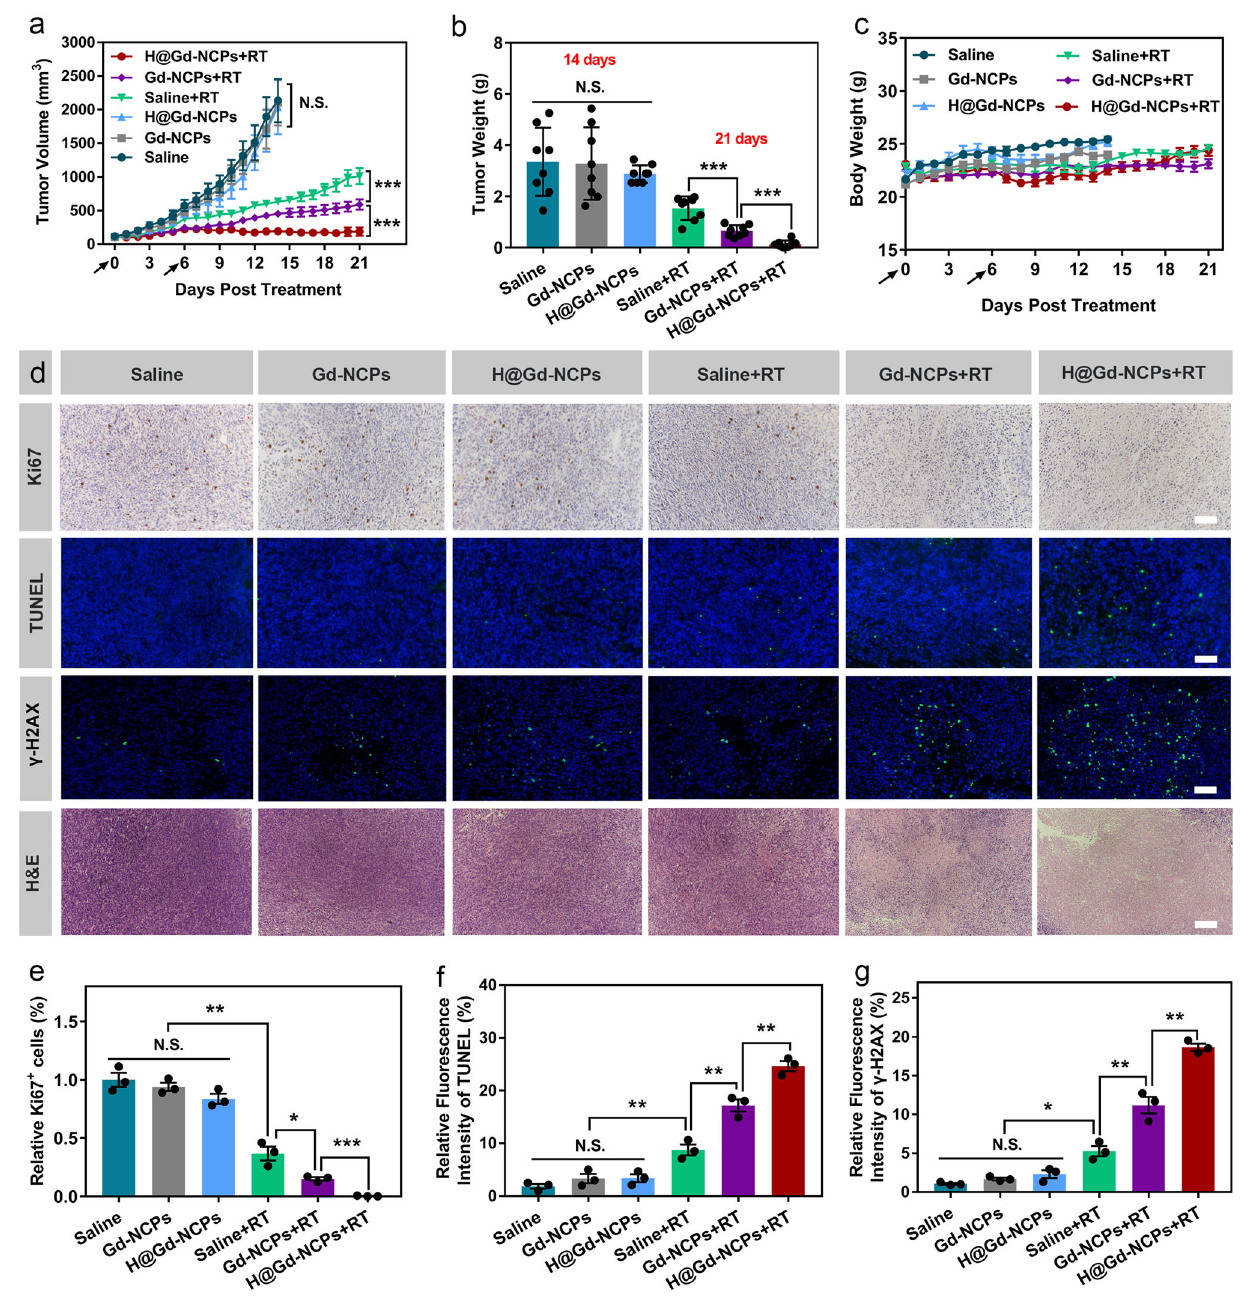
Fig. 5 Therapeutic ef fi cacy of H@Gd-NCPs in CT26-bearing mice. a Tumor growth curves after various treatments ([Gd 3 + ] = 30 mg kg − 1 and [Hemin] = 12.5 mg kg − 1 ) with or without irradiation. Treatments were performed on days 0 and 6. X-ray radiation therapy was performed 6 h after nanomedicines intravenous injection (black arrow). RT 6 Gy × 2 with fractions delivered 6 days apart ( n = 8 biologically independent animals, *** p = 0.0001). Data were presented as mean ± SEM. b Tumor weight without irradiation groups collected on day 14, tumor weight with irradiation groups collected on day 21 ( n = 8 biologically independent animals, *** p = 0.0001). c Dynamic body weight of CT26-bearing mice in different groups during treatments ( n = 8 biologically independent animals). d Images of Ki67 immunohistochemical staining of tumor slices, immuno fl uorescence images of tumor slices stained with TUNEL assay kit and γ -H2A χ antibody and H&E sections, scale bar = 100 μ m. The γ -H2A χ tumor slices were harvested 24 h after radiotherapy (6 Gy × 1) and the Ki67, TUNEL tumor slices were harvested 48 h after radiotherapy (6 Gy × 1). These experiments were repeated twice independently with similar results. e – g Quanti fi cation of the relative percentage of ( e ) Ki67 positive cells (** p = 0.0016, * p = 0.0227, *** p = 0.0005) ( f ) TUNEL (** p = 0.0035, ** p = 0.0053, ** p = 0.0072) and γ -H2A χ (* p = 0.0364, ** p = 0.0093, ** p = 0.0031) mean fl uorescence intensity after different treatments ( n = 3 biologically independent animals). Data ( b , c , e – g ) were presented as mean ± SD. Two-sided Student ’ s t -test was used to calculate the statistical difference between two groups. N.S. represented non-signi fi cance, and * p < 0.05, ** p < 0.01, *** p < 0.001. Source data are provided as a Source data fi le.